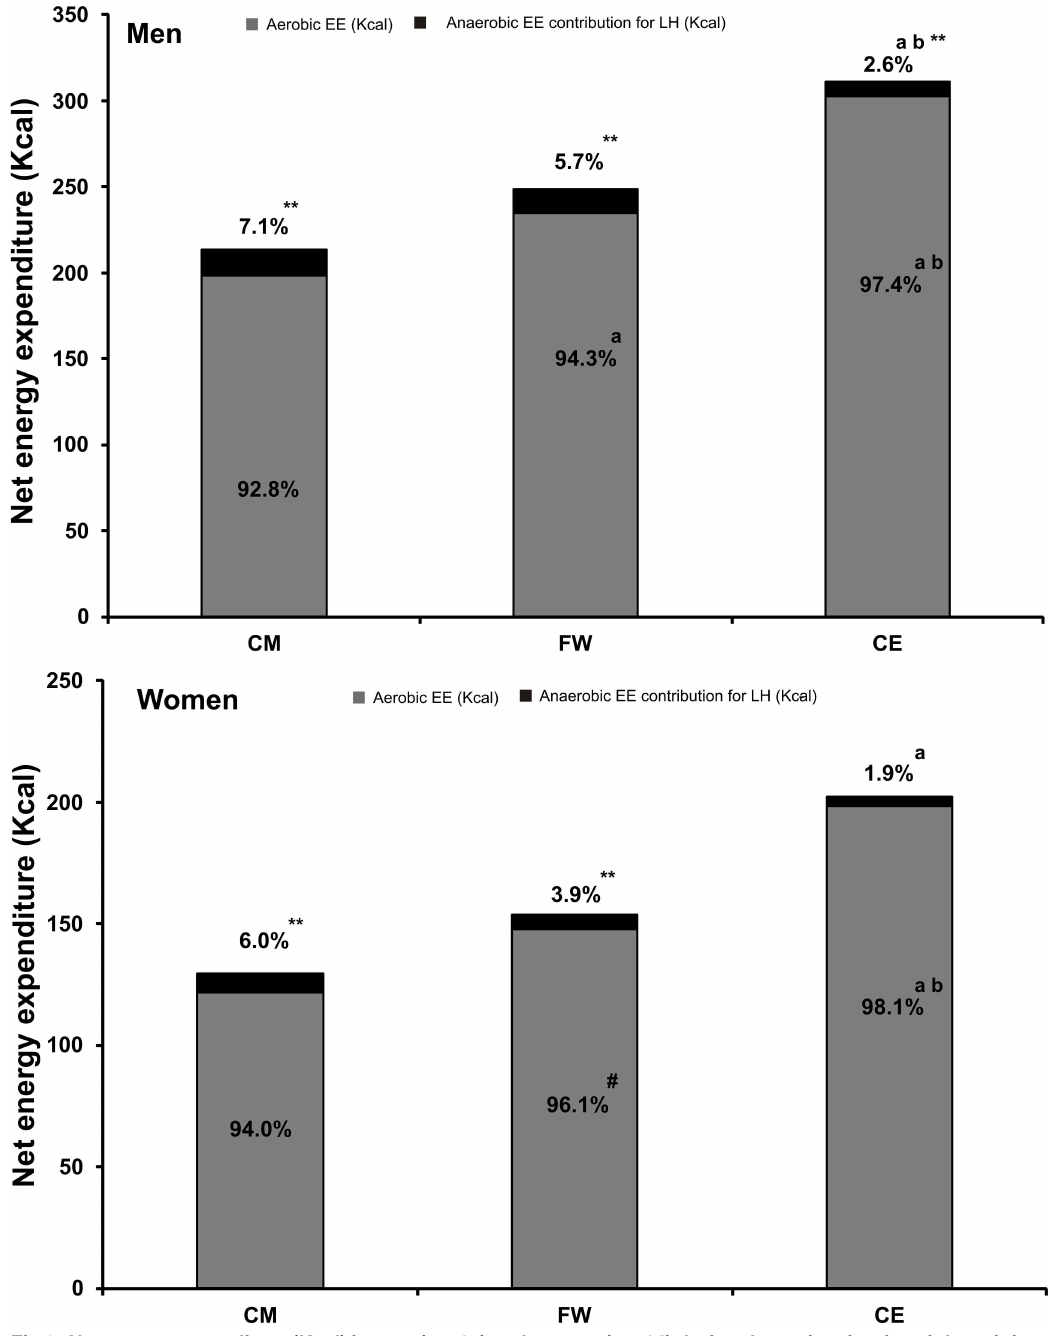
Fig 3. Net energy expenditure (Kcal) in men (n = 15) and women (n = 14) during the entire circuit weight training protocol. Percentagesrepresent the individualcontribution of aerobic energy expenditure (grey) and anaerobicenergy expenditure (black) to total energy expenditure. CM: Circuit Machine trainingprotocol; FW: Free Weight-training protocol; CE: CombinedExercise training protocol. a p < 0.05 with CM, b p < 0.05 with FW, ** p < 0.001 aerobic energy expenditure with total energy expenditure(aerobic + anaerobic)(P < 0.001), # p = 0.06 with CM.